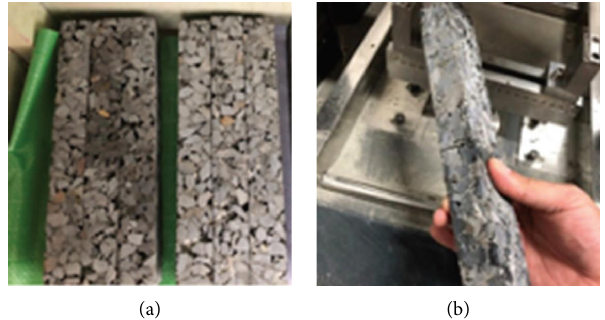
Figure 11: Damaged specimens after the fexural and tensile test. (a) Prismatic specimens before the test. (b) Te specimen after the test.